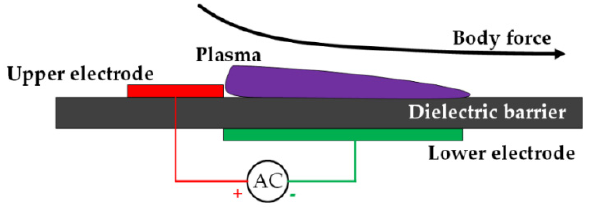
Figure 2. Sketch of the dielectric barrier discharge (DBD) plasma actuator.